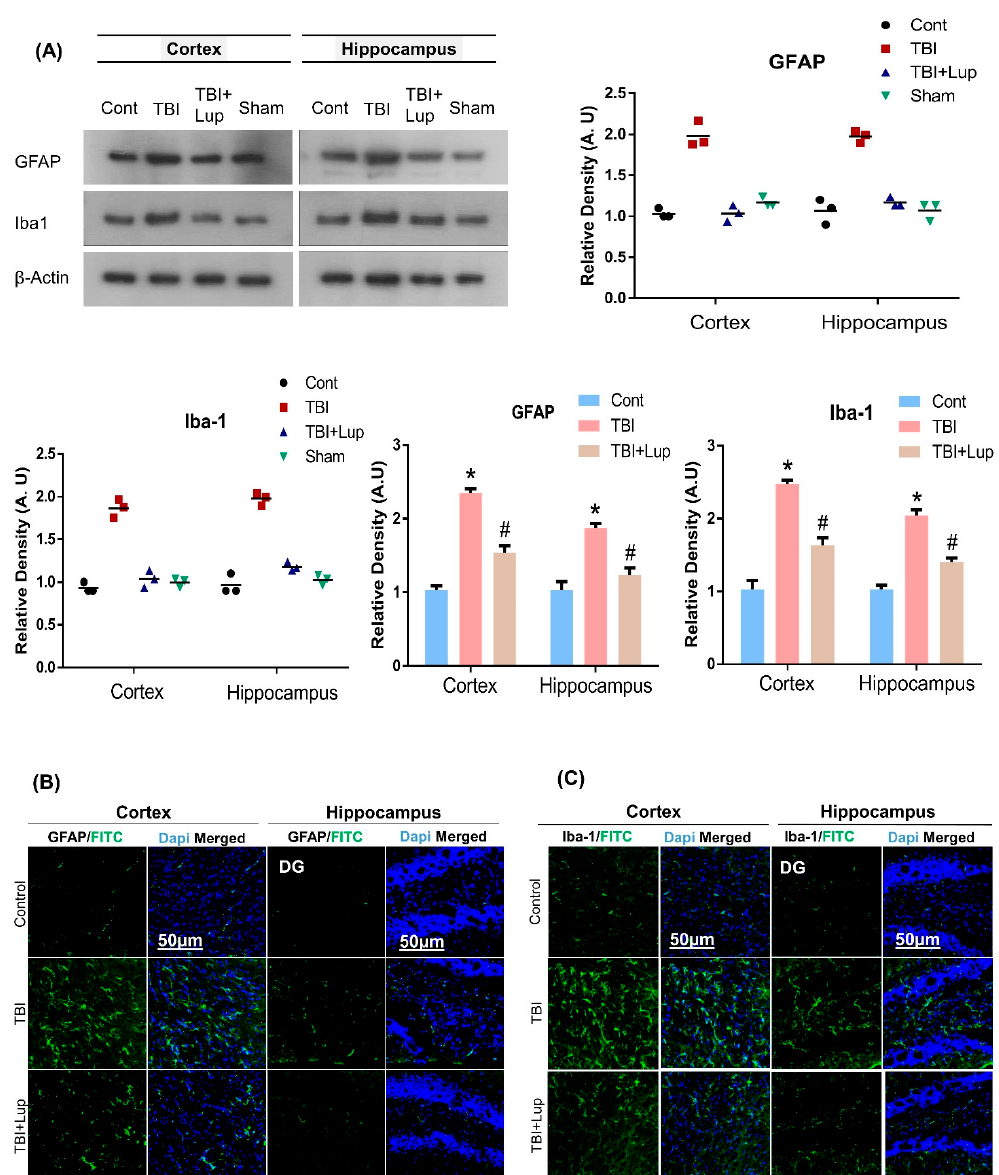
Figure 1. Lupeol ameliorates TBI-induced microglia/astrocytes activation in mouse brain: ( A ) West- ern blot analysis showing the expression of GFAP and Iba-1 in the experimental mice (cortex and hippocampus regions); ( B,C ) confocal photomicrographs showing the immunoreactivity of GFAP and Iba-1 (FITC—green), stained with DAPI (blue) in the cortex and DG region of hippocampus in different mice groups. The cropped bands were quantified using Image software, and the differ- ences are represented in the histogram. Asterisk (*) sign indicates significant difference from the normal saline-treated group; hash (#) sign indicates significant difference from the TBI-treated group. Bar = 50 µ m. The density values are expressed in arbitrary units as the mean ± SEM of the indicated proteins ( n = 6 animals per group). Significance = p ≤